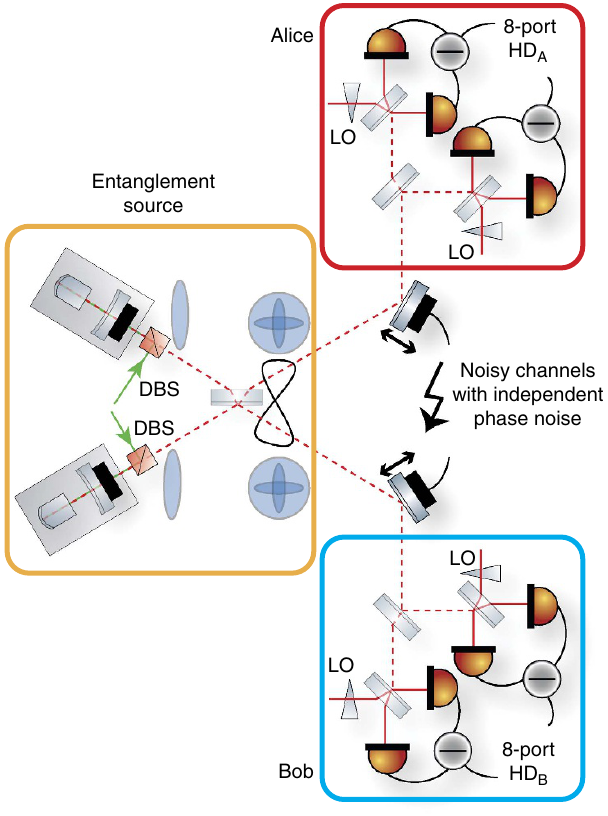
Figure 4 | Experimental setup. Two propagating squeezed-light modes are superimposed on a balanced beam splitter. The entangled outputs are sent to two separate sites. During transmission the modes are exposed to phase noise, which produces de-Gaussified mixed quantum states. For strong phase noise the two-mode squeezing, that is, the entanglement in the second moments of the quadratures, is completely destroyed. The decohered modes are continuously and unconditionally detected by eight- port homodyne detectors, which have negligible intrinsic phase noise and detection efficiencies of about 87 ± 6%. DBS, dichroic beam splitter.